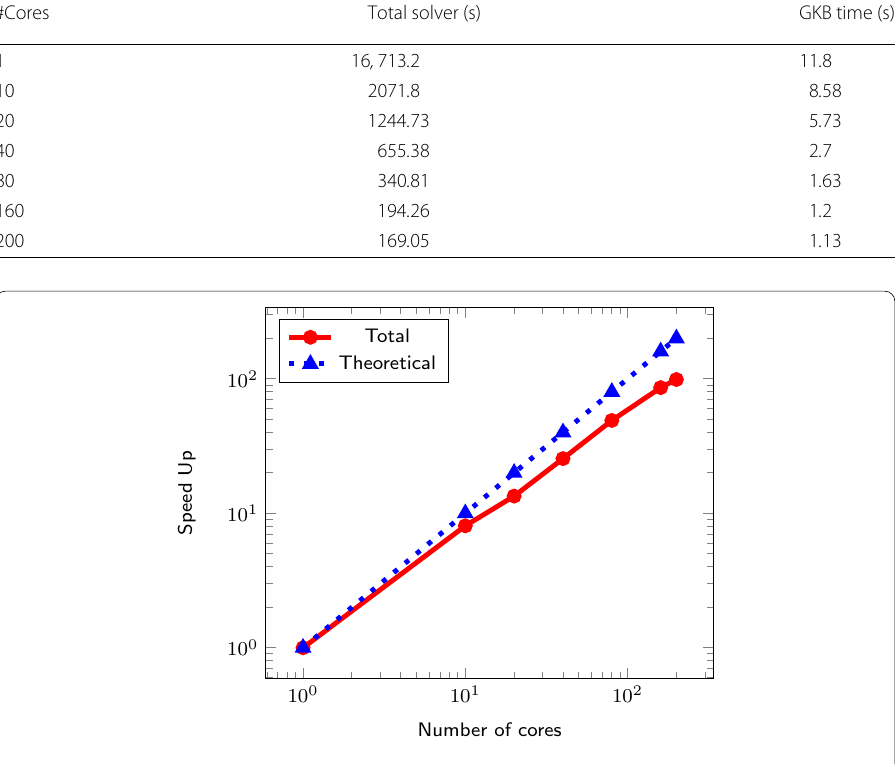
Table 7 Summary of the run times of the strong scalability of the GKB algorithm for a prestressed concrete block of sizes m = 1538103 and n = 750000